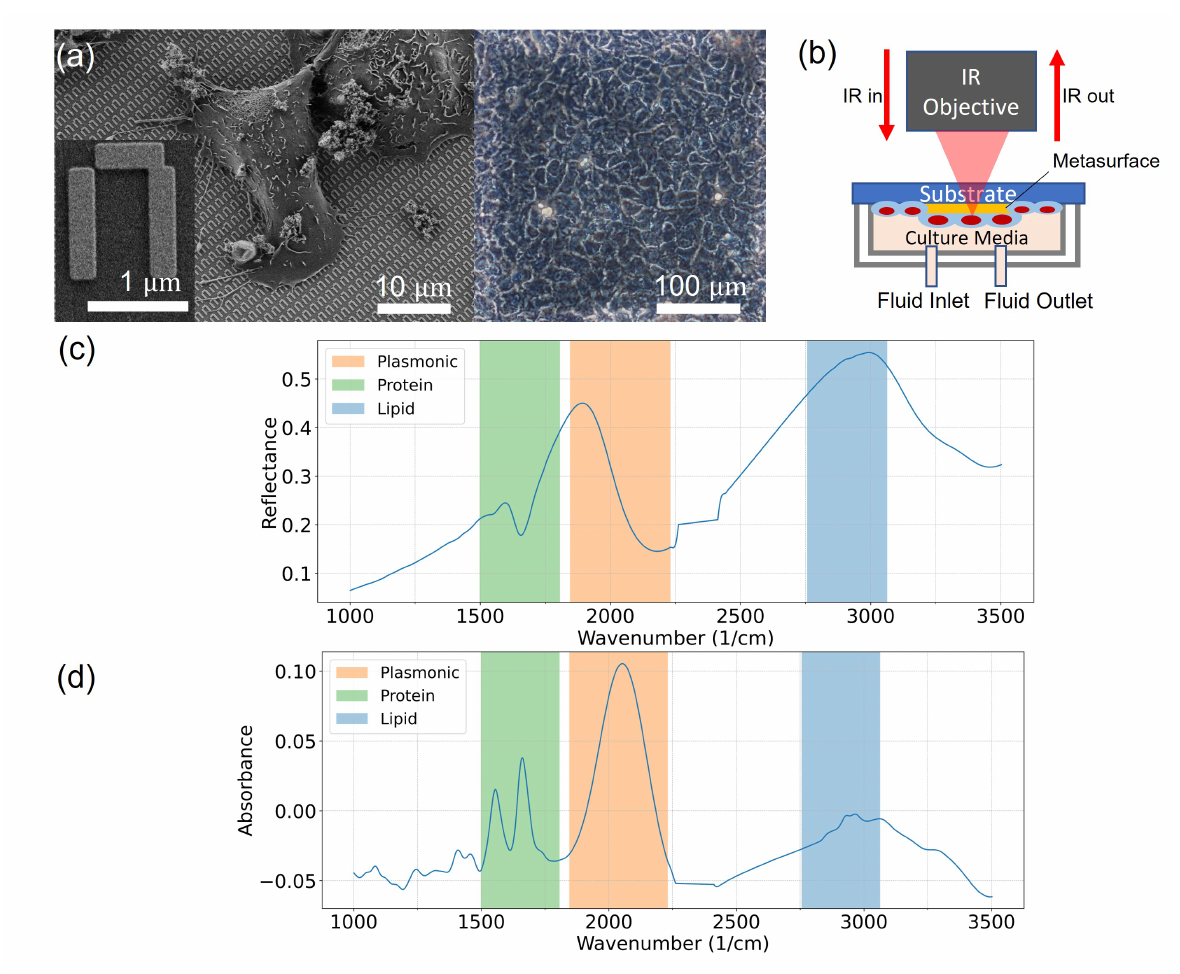
Figure 1. MEIRS setup and live cells spectra. ( a ) Left: SEM image of A431 cells cultured, subsequently fixed on the metasurface. The left corner is a zoomed-in single meta-atom. Right: phase contrast microscopy image of live A431 cells on a pixel of the metasurface (shaded square area of 300 µ m × 300 µ m). ( b ) Measurement setup: metasurface with live cells is sealed in a PDMS microfluidic chamber used for delivering cell culture and drugs. Reflectance spectra were collected from the top through IR-transparent substrate. The setup is described elsewhere [28]. ( c ) Reflectance spectrum R ( ω ) of A431 cells on the metasurface prior to drug treatment. Bio-relevant spectral windows are shaded: proteins (green, 1498 < ω < 1807 cm − 1 ), plasmonic resonance (orange, 1845 < ω < 2231 cm − 1 ), and lipids (blue, 2756 < ω < 3064 cm − 1 ). Reflectance in the plasmonic resonance region is a proxy for refractive index changes due to cells’ presence on the metasurface. ( d ) Total cell absorbance spectrum A ( ω ) of A431 cells on the metasurface extracted from the reflectance spectrum R ( ω ) as [ R ( ω ) / R ( ω )] , where R ( ω ) is the average reflectance spectrum of the metasurface A ( ω ) = − log 0 0 10 with no